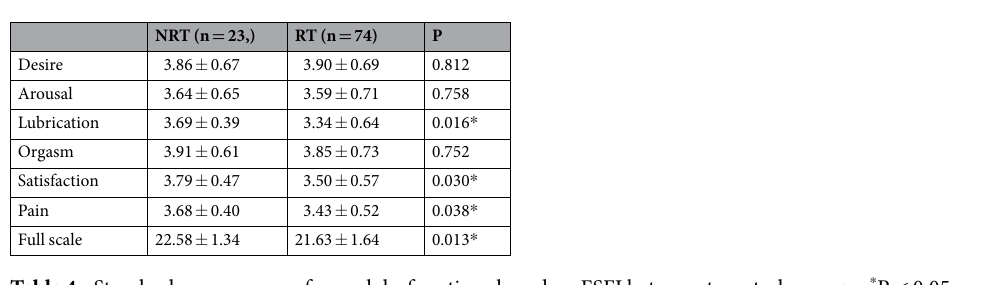
Table 4. Standard mean scores of sexual dysfunctions based on FSFI between two study groups. * P < 0.05.